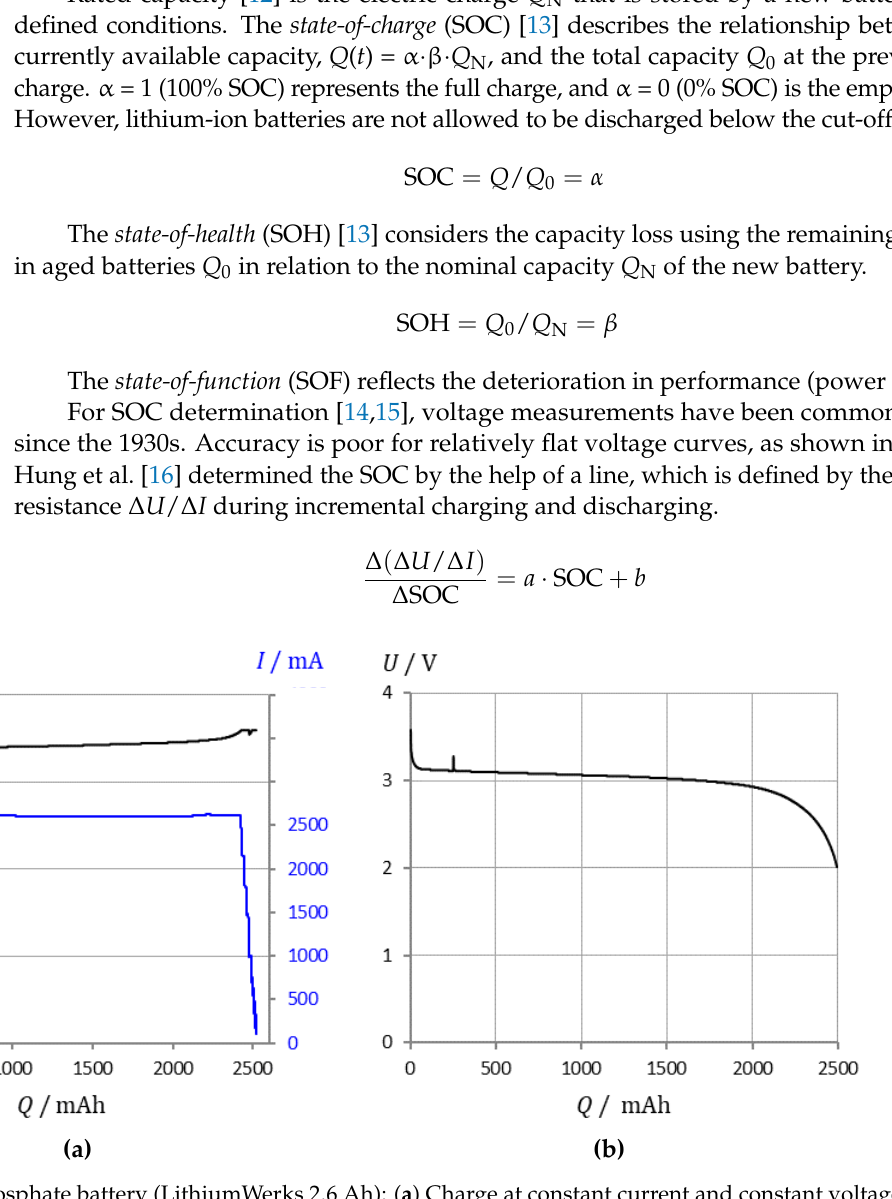
Figure 1. Lithium iron phosphate battery (LithiumWerks 2.6 Ah): ( a ) Charge at constant current and constant voltage. ( b ) Flat discharge profile. EIS measurements were performed from 100% to 30% state-of-charge (SOC) in 2% steps.